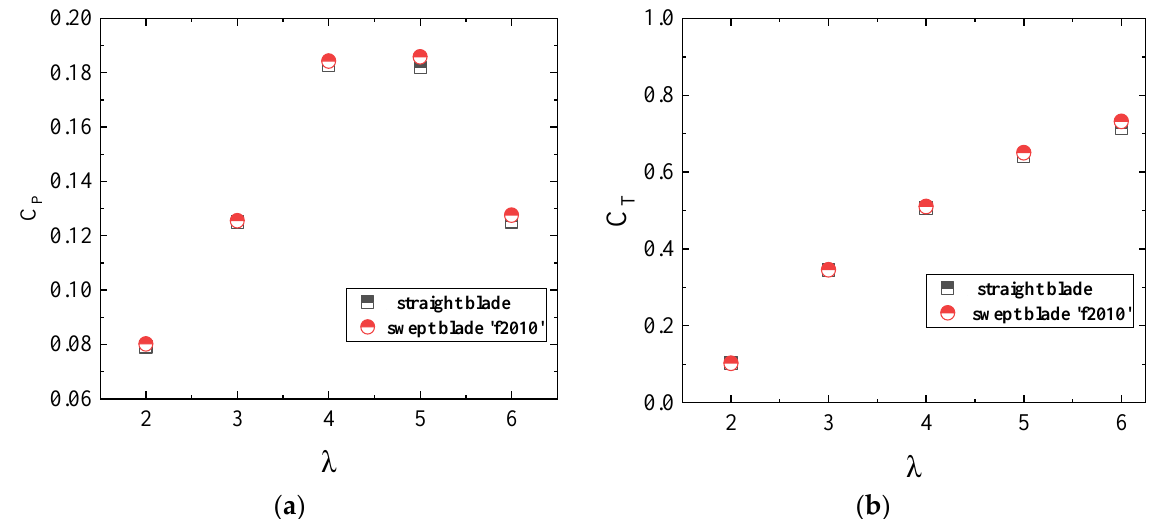
Figure 6. Comparison of coefficient curves for the wind turbines with straight blades and the swept blades ‘ f2010 ’ . ( a ) C P - λ curves; ( b ) C T - λ curves.